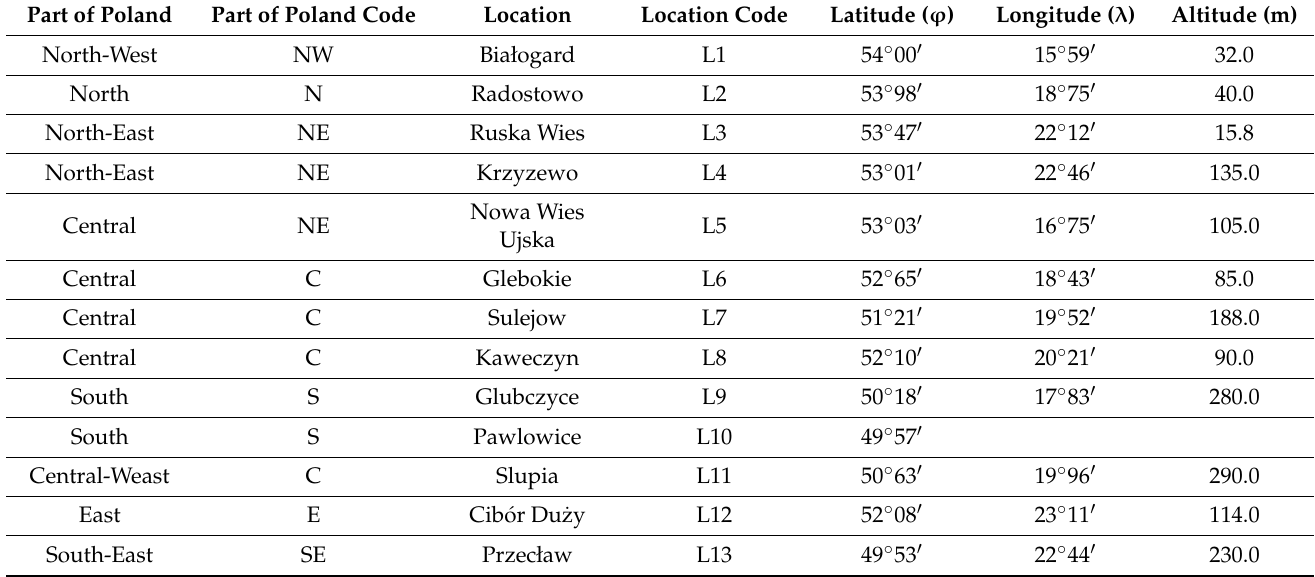
Table 1. List of locations of post-registration multi-environment variety system testing trials (PRVTS) conducted in moderate input management system, their symbol code, part of Poland symbol codes, and information about geographic